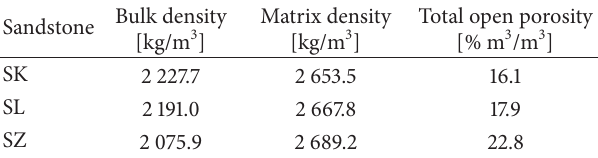
Table 4: Basic physical properties.